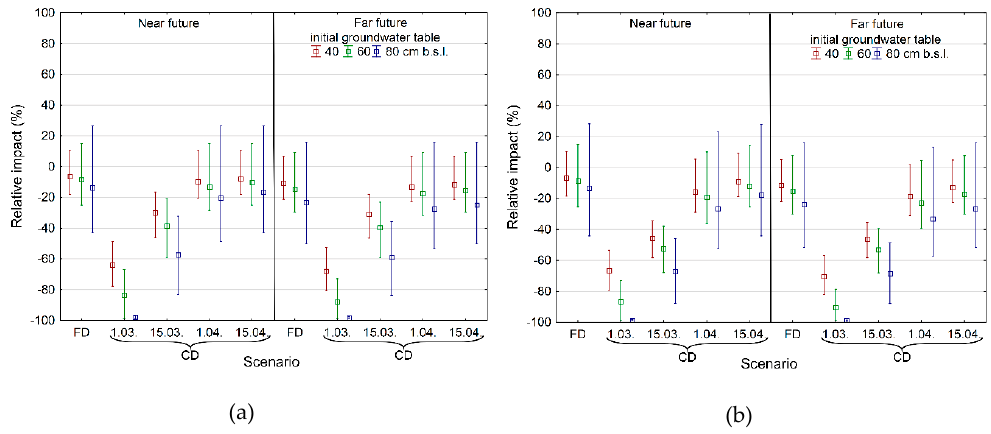
Figure 8. Changes in subsurface outflows from 7 m ( a ) and 14 m ( b ) spacing drainage networks for the FD and CD scenarios in the near and far future, in relation to subsurface outflows from FD networks. Bar charts with error bars show the average values, as well as the minimum and maximum values for the years 2014, 2017, and 2018.